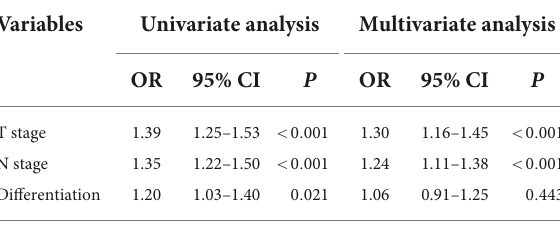
TABLE 2 Risk factors for body mass index changes identified by logistic